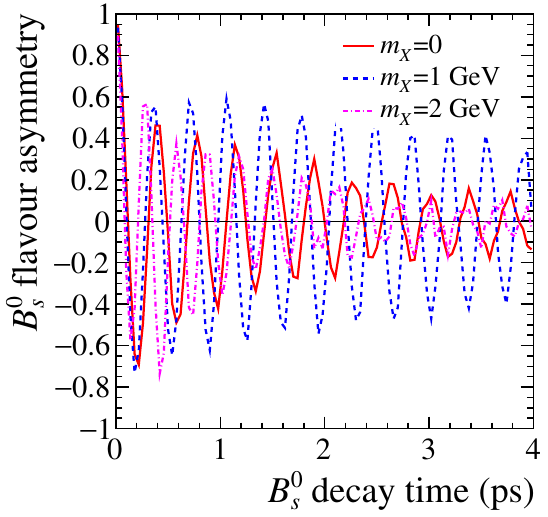
Figure 4 . Dependence of B 0 (cid:13)avour asymmetry on decay time t for the true X mass M X = 1 GeV, s for di(cid:11)erent assigned masses m X